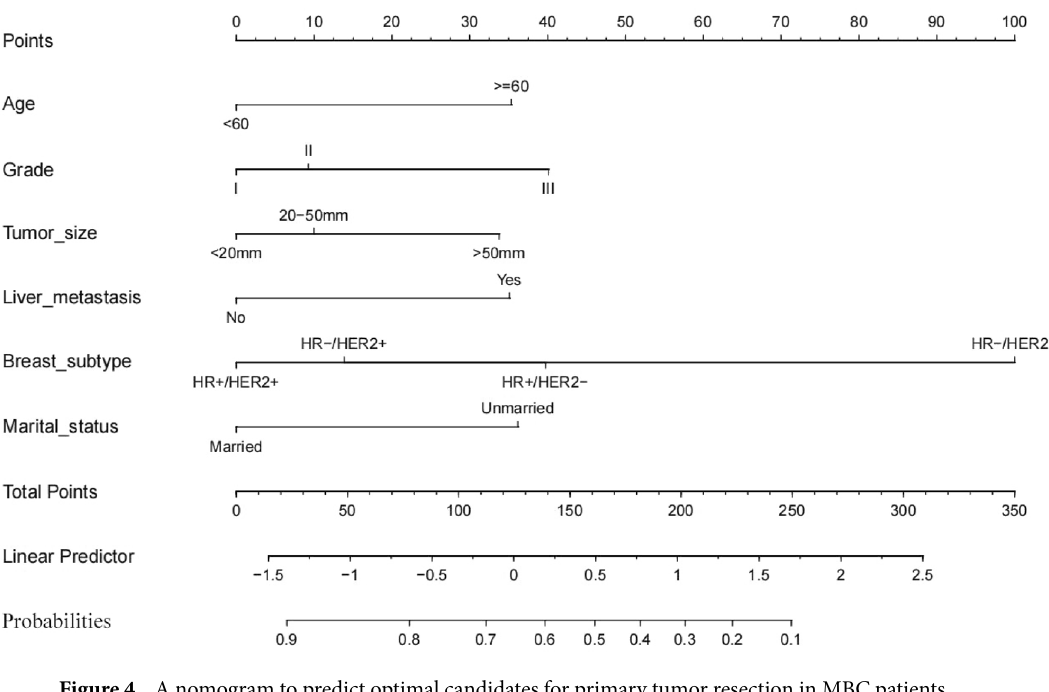
Figure 4. A nomogram to predict optimal candidates for primary tumor resection in MBC patients.